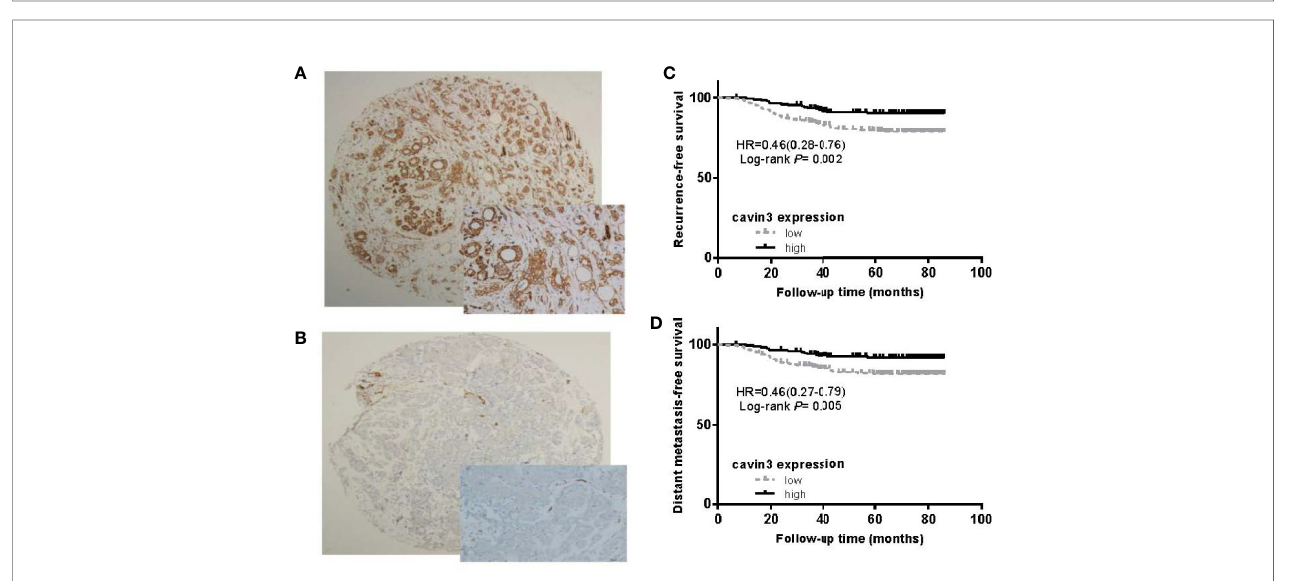
FIGURE 2 | Expression of cavin3 in breast cancer and its impact on cancer survival. (A) Diffusely and strongly positive expression of cavin3 (H-score was 270); (B) completely negative expression of cavin3 (H-score was 0); (C) Low cavin3 (H-score ≤ 50) is associated with worse recurrence free survival; (D) Low cavin3 (H-score ≤ 50) is associated with worse distant metastasis-free